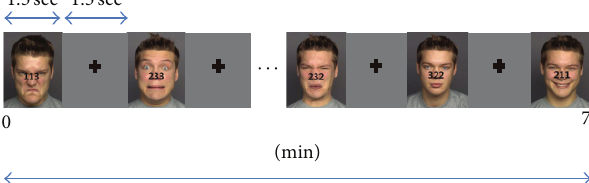
Figure 1: Schematic representation of the experiment